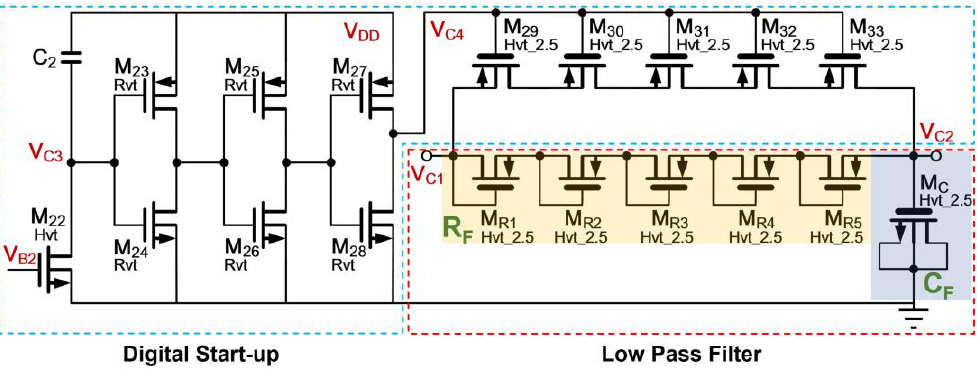
Figure 7. Low pass filter with digital start-up. The size of each component, which are pertaining to the proposed PSR enhancer in Figure 6 and the low pass filter in Figure 7 are given in Table